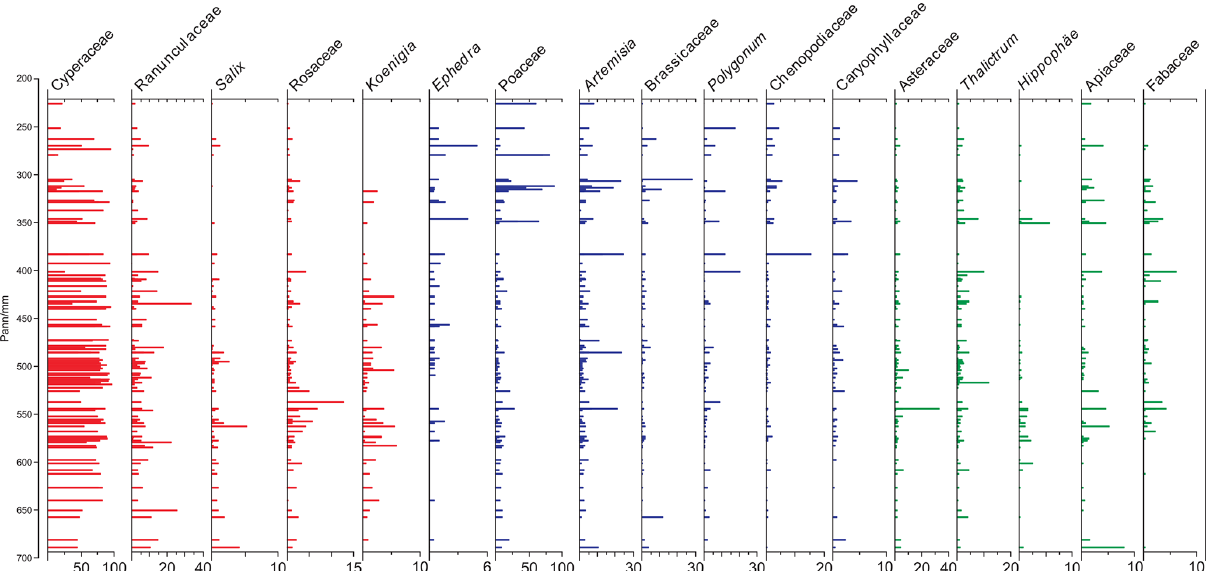
Figure 2. Pollen diagram showing the major taxa (percentage; %) of the 117 samples arranged by mean annual precipitation ( P ann ; mm). Pollen taxa with red bars are positively related to P ann , those with blue bars are negatively related to P ann , and the relationship is insignificant for those with green bars.